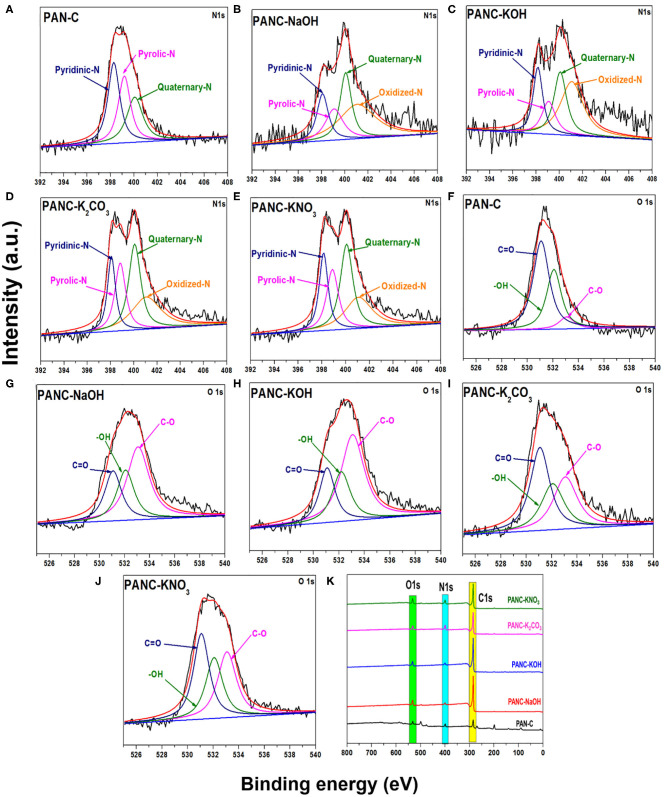
XPS N 1s scan of (A) PAN-C (B) PANC-NaOH (C) PANC-KOH (D) PANC-K2CO3
(E) PANC-KNO3 and O 1s scan of (F) PAN-C, (G) PANC-NaOH, (H) PANC-KOH, (I) PANC-K2CO3 and (J) PANC-KNO3, and (K) XPS survey analysis of all synthesized absorbents respectively.